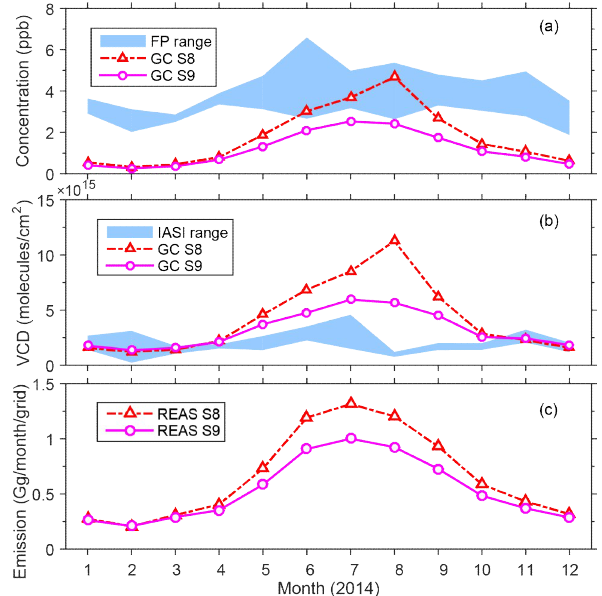
Figure 8. Time series of NH 3 in the Kanto region ( a ) FP and GEOS-Chem concentrations, ( b )